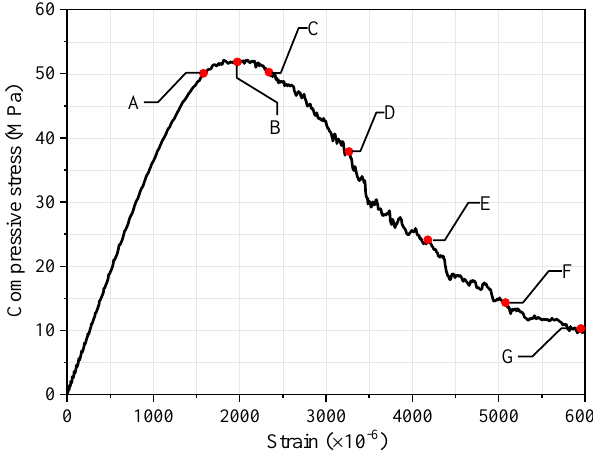
Figure 12. Statistical characteristic of global stress-strain curve under compression.